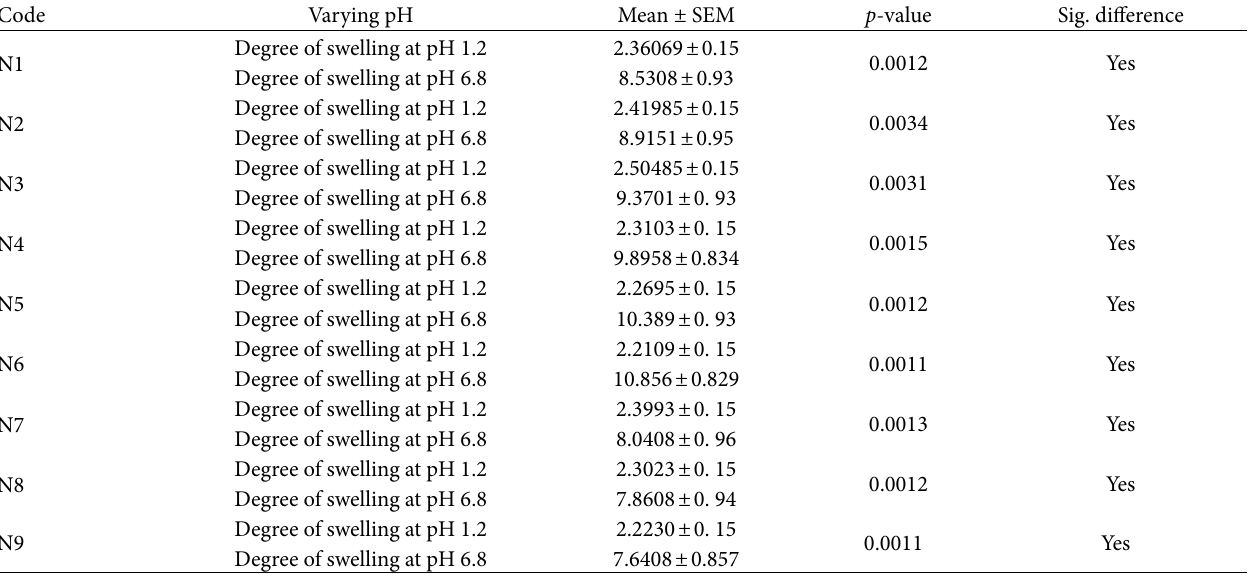
Table 7: Comparison between swelling of all formulation at pH 1.2 and pH 6.8.